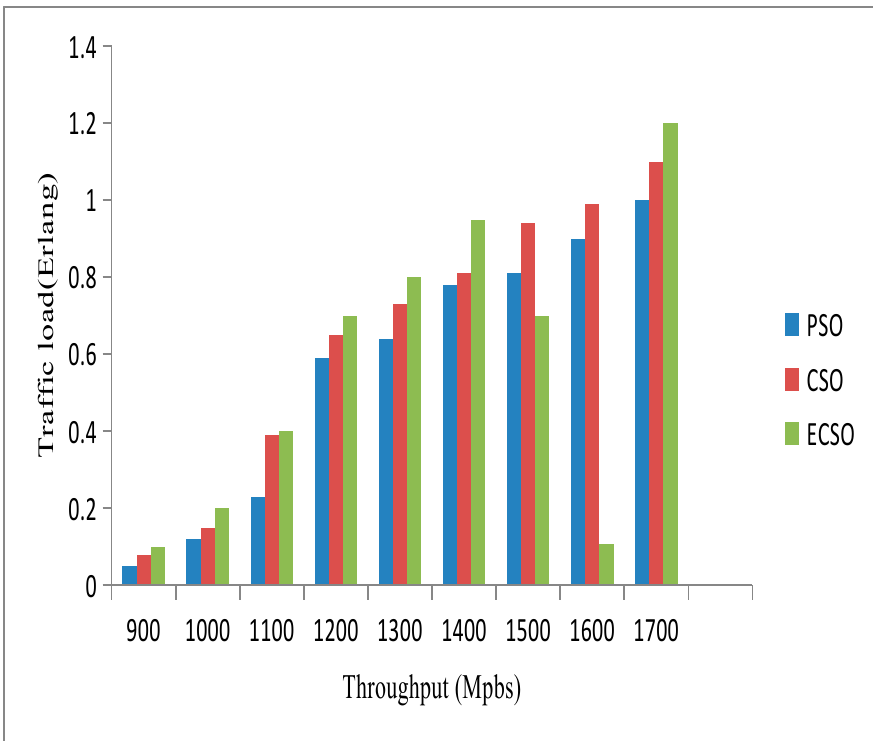
Figure 9. Comparative analysis of throughput against existing methods.